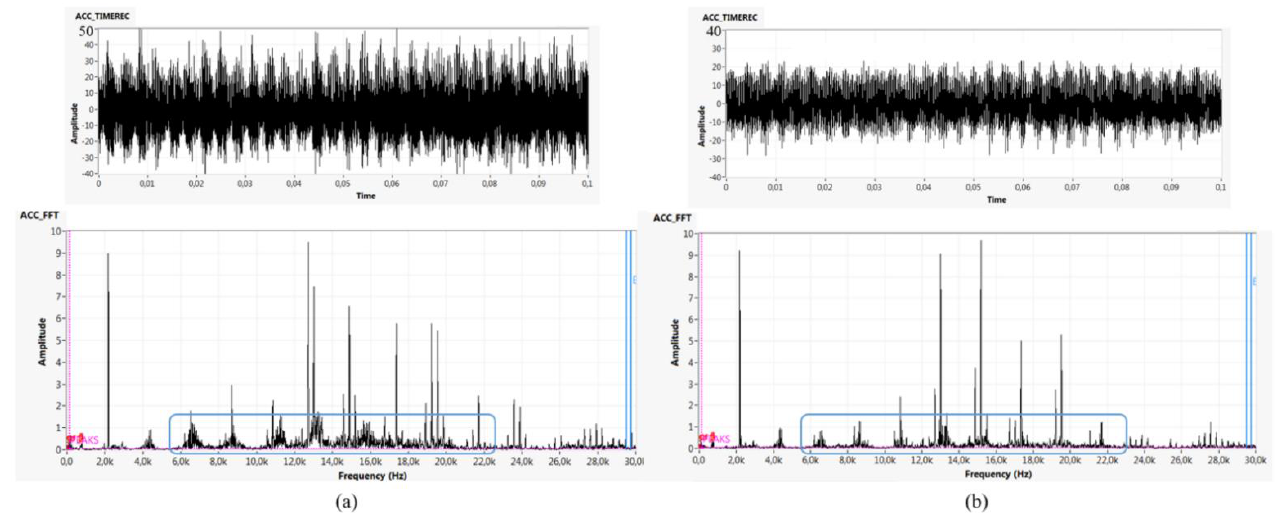
Figure 5. Time record (up) and fast Fourier transformation (FFT) spectrum (below) for a structure with no damper ( a ) and a structure with passive damper type 2 ( b ).